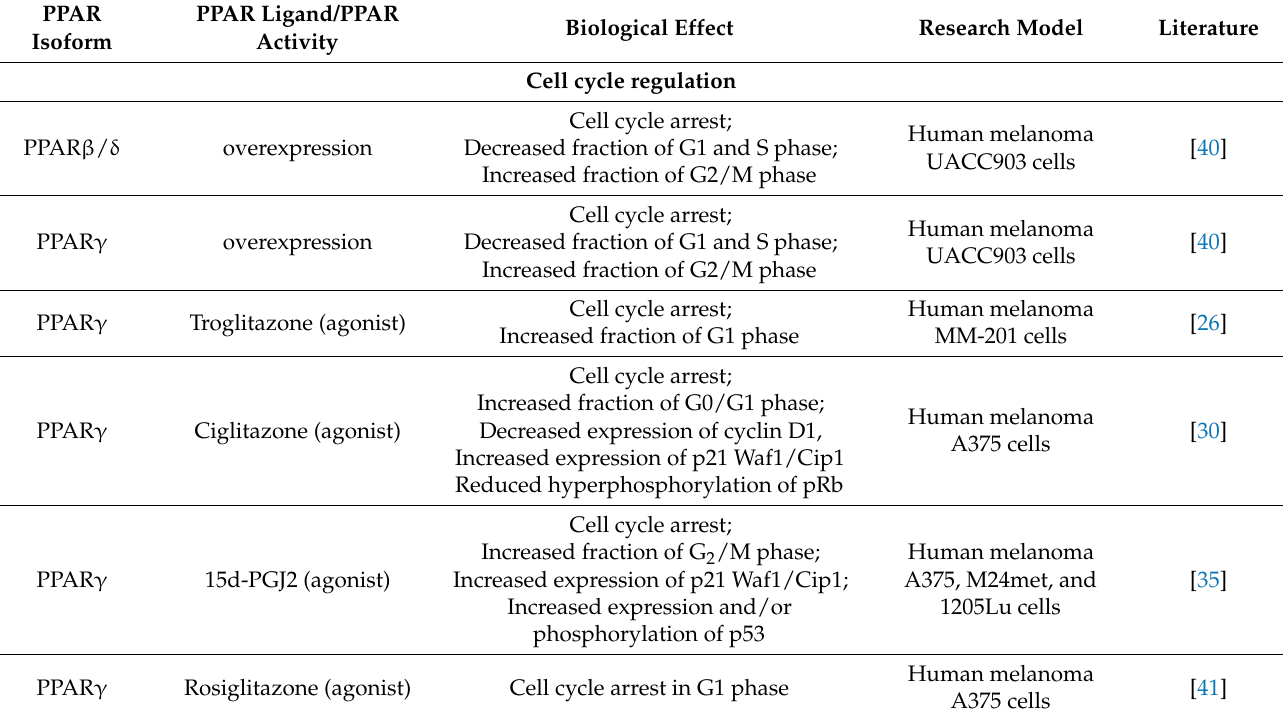
Table 1. The biological activities of PPARs in